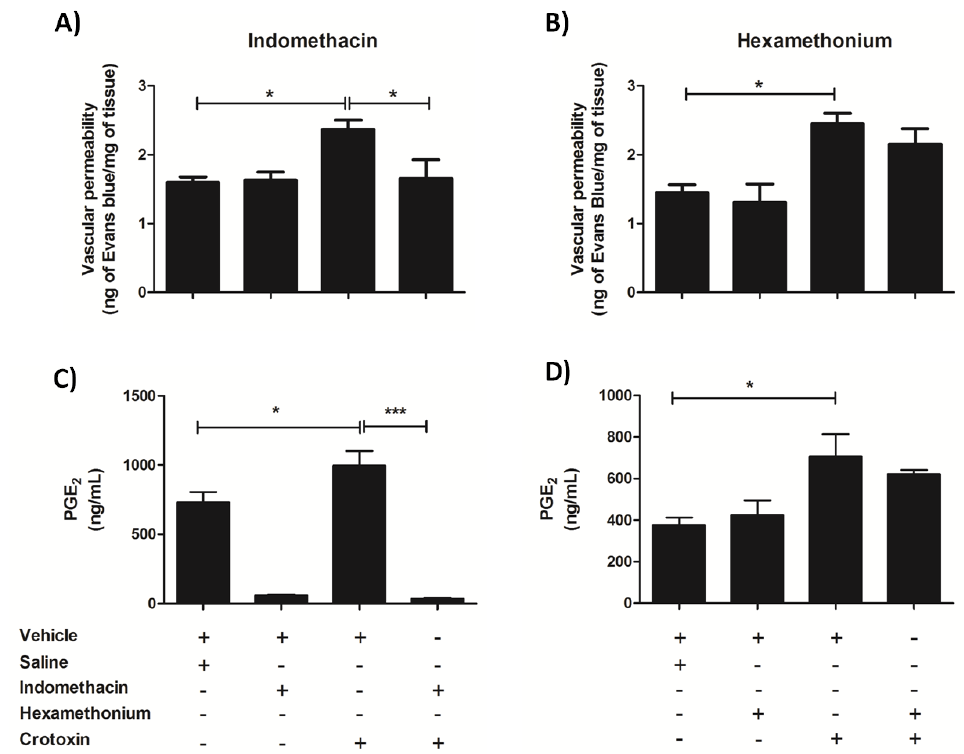
Figure 7. Effect of indomethacin and hexamethonium on CTX-induced early phase lung alterations. Mice were treated with indomethacin (3 mg/Kg i.p.; panels ( A , C )), hexamethonium (10 mg/Kg i.v.; panels ( B , D )), or their respective vehicles, before CTX (300 µg/Kg s.c.) administration. After 2 h, lungs were collected for ( A , B ) analysis of vascular permeability using the Evans blue extravasation assay and ( C , D ) quantification of prostaglandin E 2 (PGE 2 ) by ELISA. The results are representative from one independent experiment ( n = 4 animals/group). * P < 0.05 and *** P < 0.001 — one-way ANOVA followed by the Tukey’s multiple comparison test.